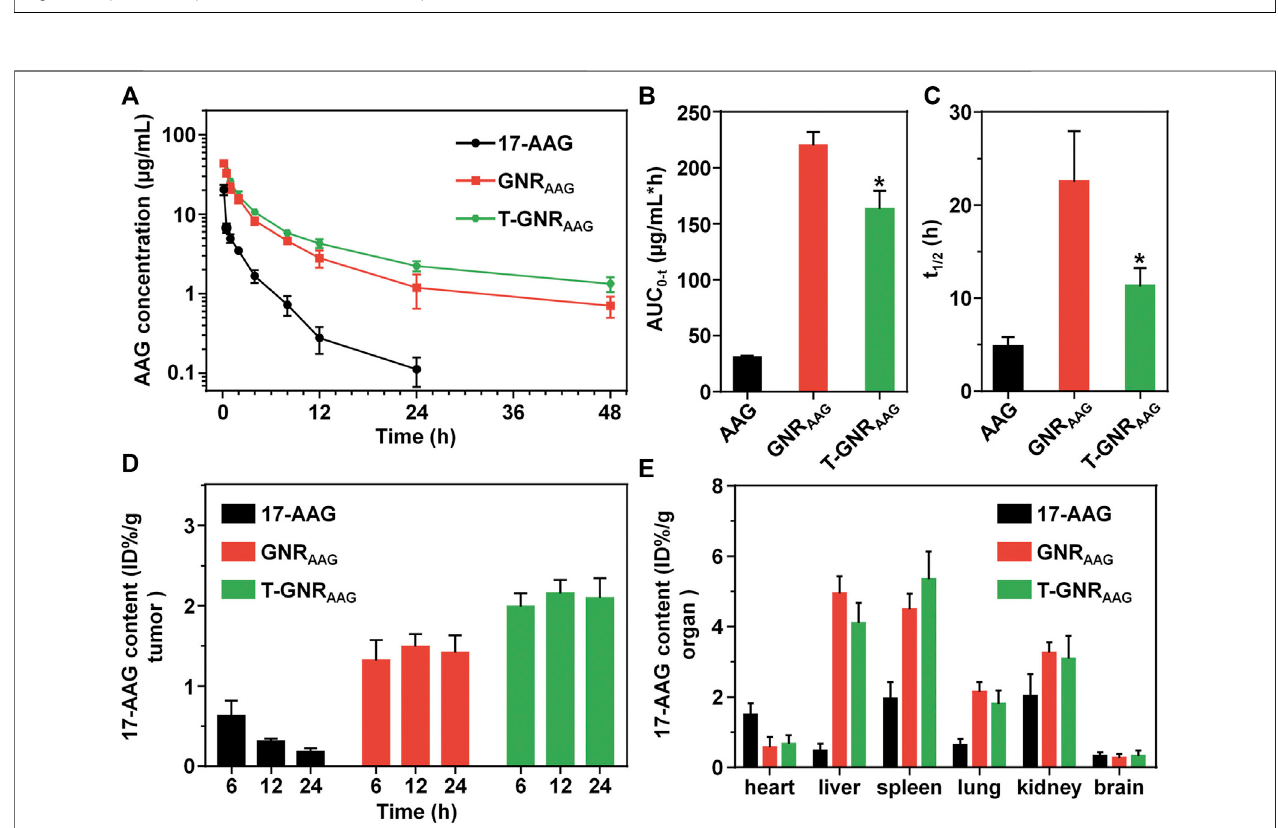
Frontiers in Materials |